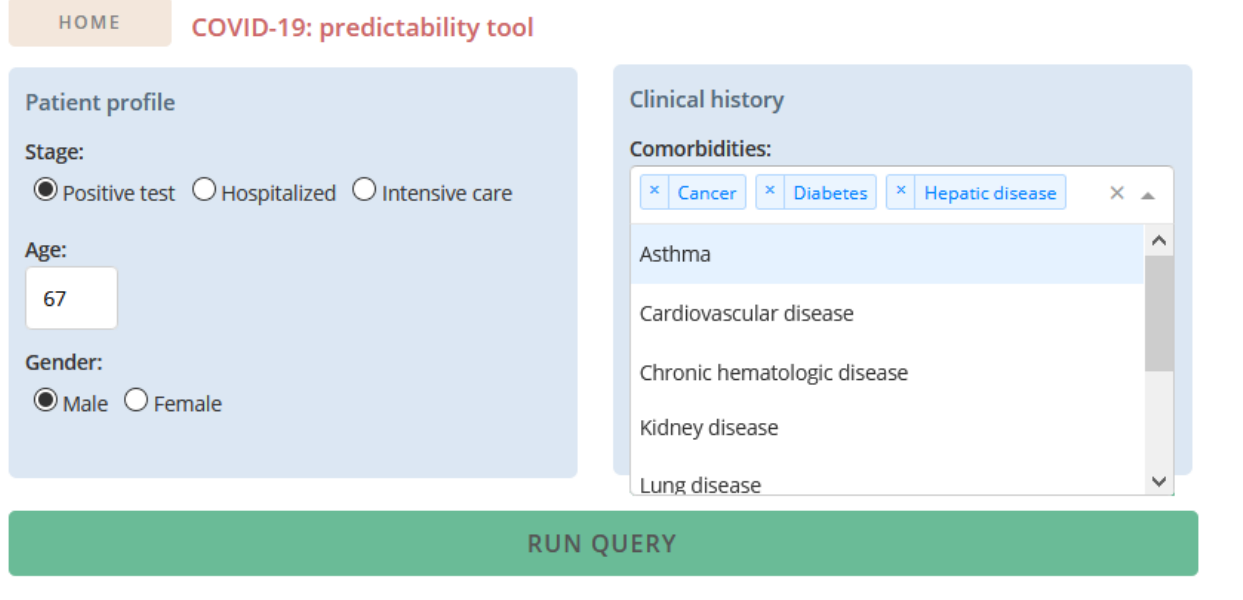
Figure 14. Snapshot of the provided clinical decision support